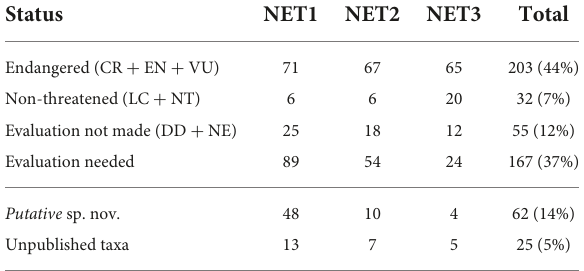
TABLE 2 Summary of narrow endemic taxa (NET) listed with their IUCN status established by the RLA-NC.